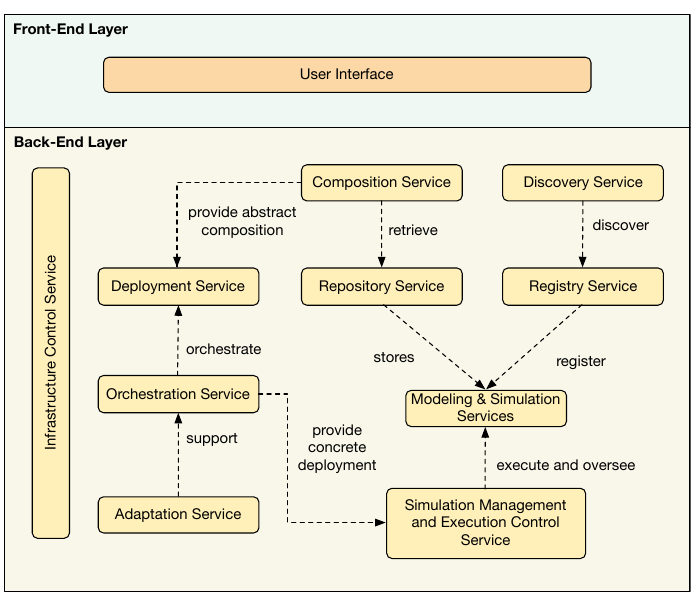
Figure 3. MSaaS reference